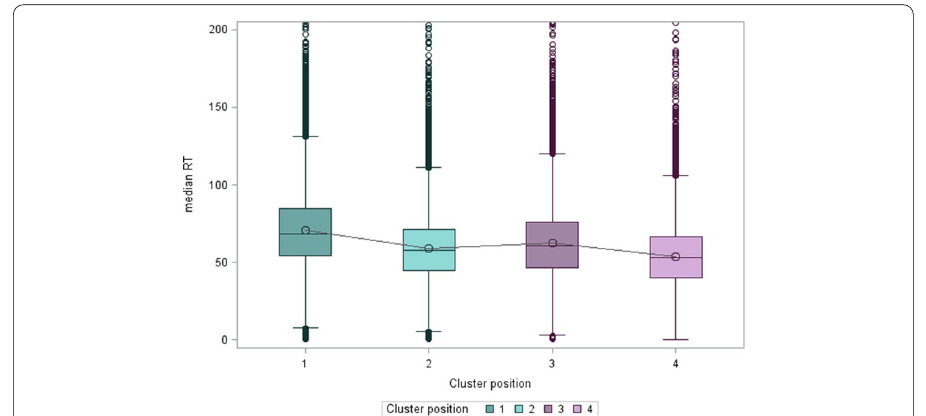
Fig. 2 Boxplot of student median RT by cluster position (outliers above 200 s are not